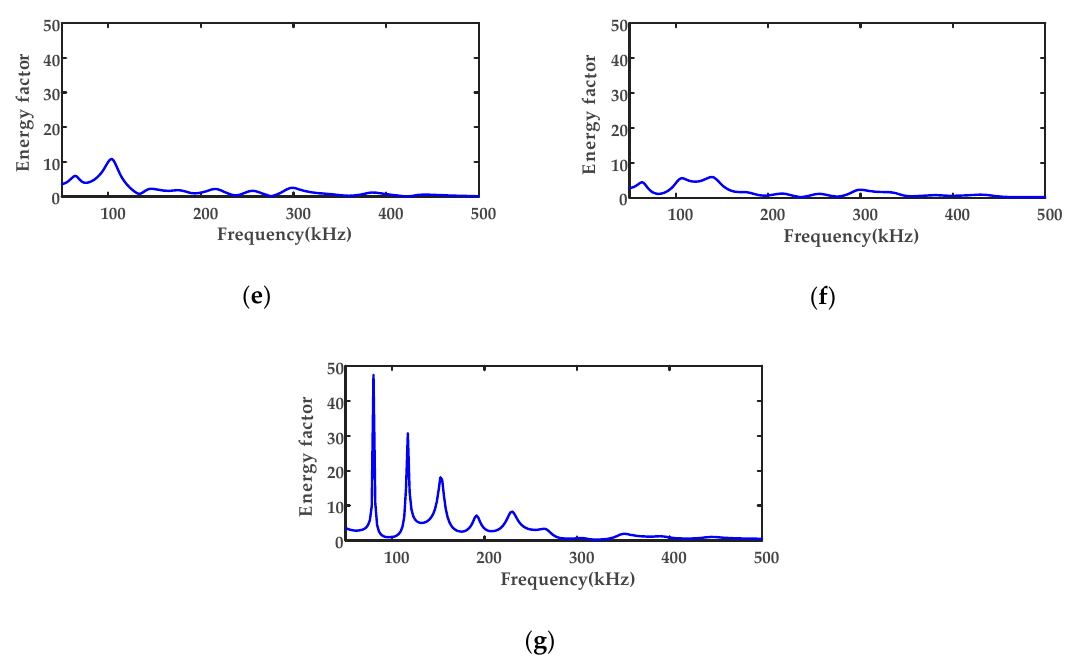
Figure 8. Energy factor curves: ( a ) point 1; ( b ) point 2; ( c ) point 3; ( d ) point 4; ( e ) point 5; ( f ) point 6; ( g ) point 7.